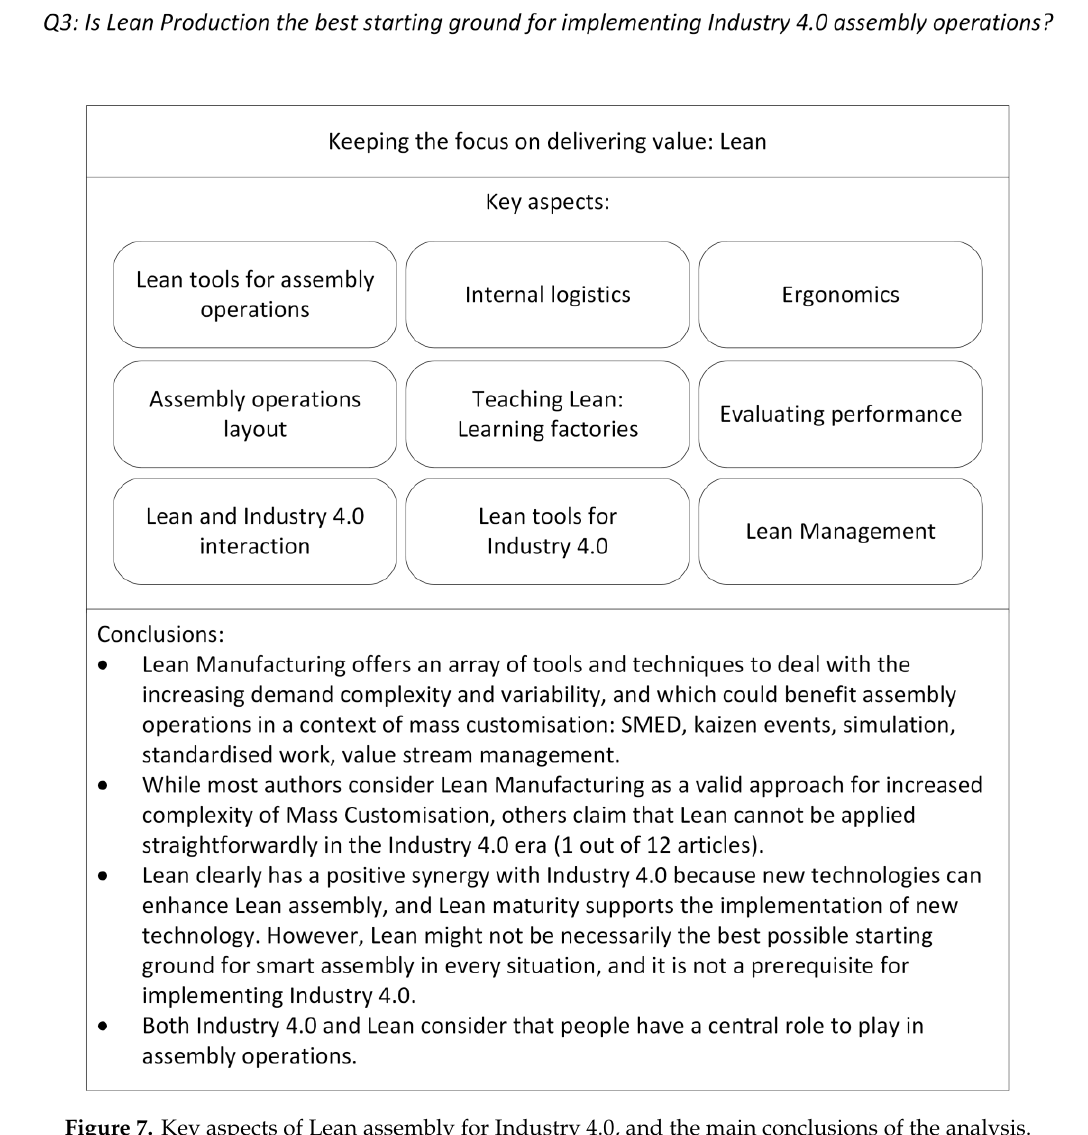
Figure 7. Key aspects of Lean assembly for Industry 4.0, and the main conclusions of the analysis.